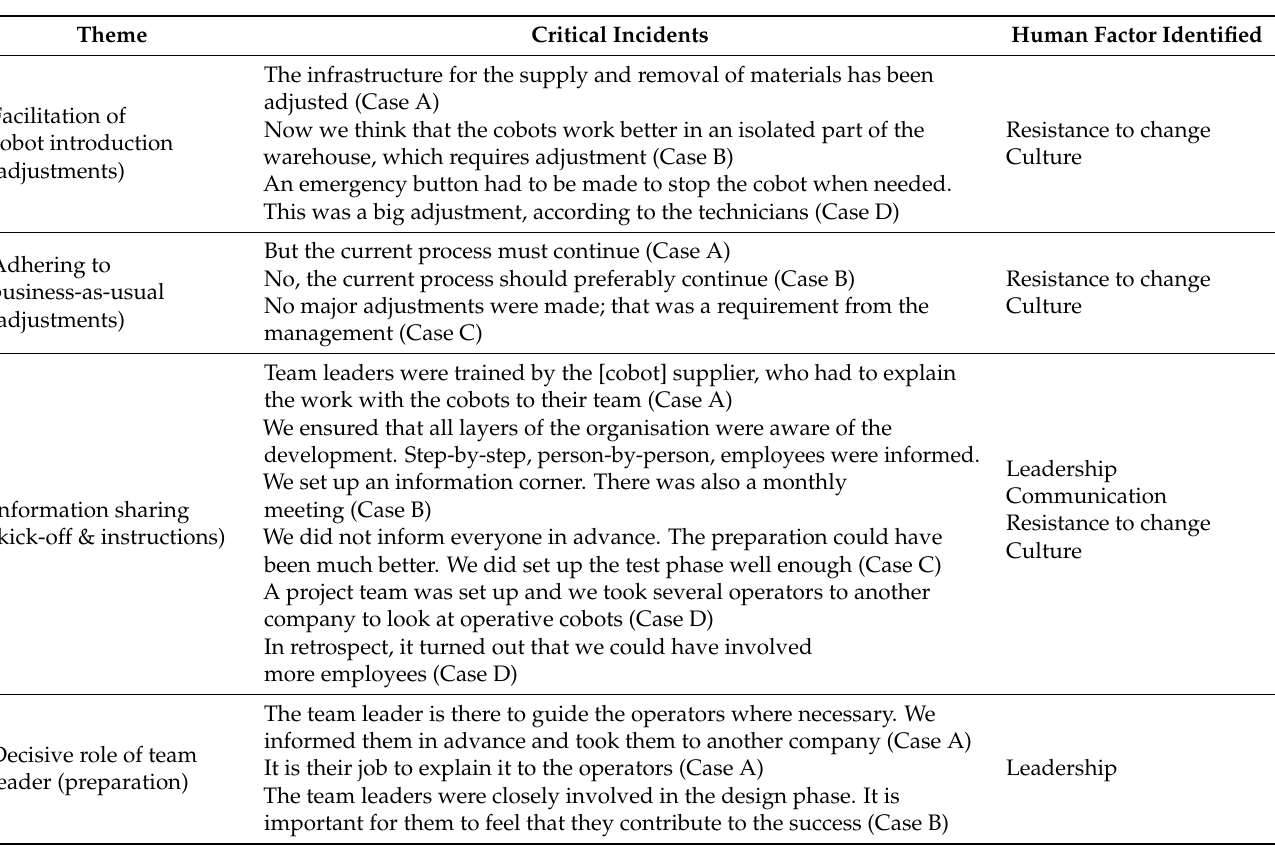
Table 2. Critical incidents and human factors identified related to adjustments; kick-off; and preparation of the implementation